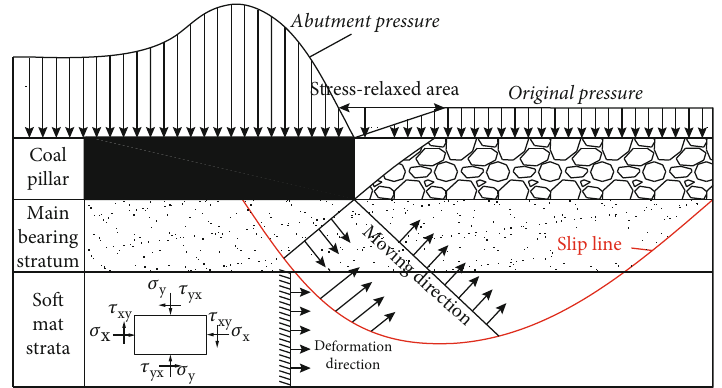
Figure 6: Displacement fi eld of coal and rock mass in slip fi eld of coal pillar fl oor.